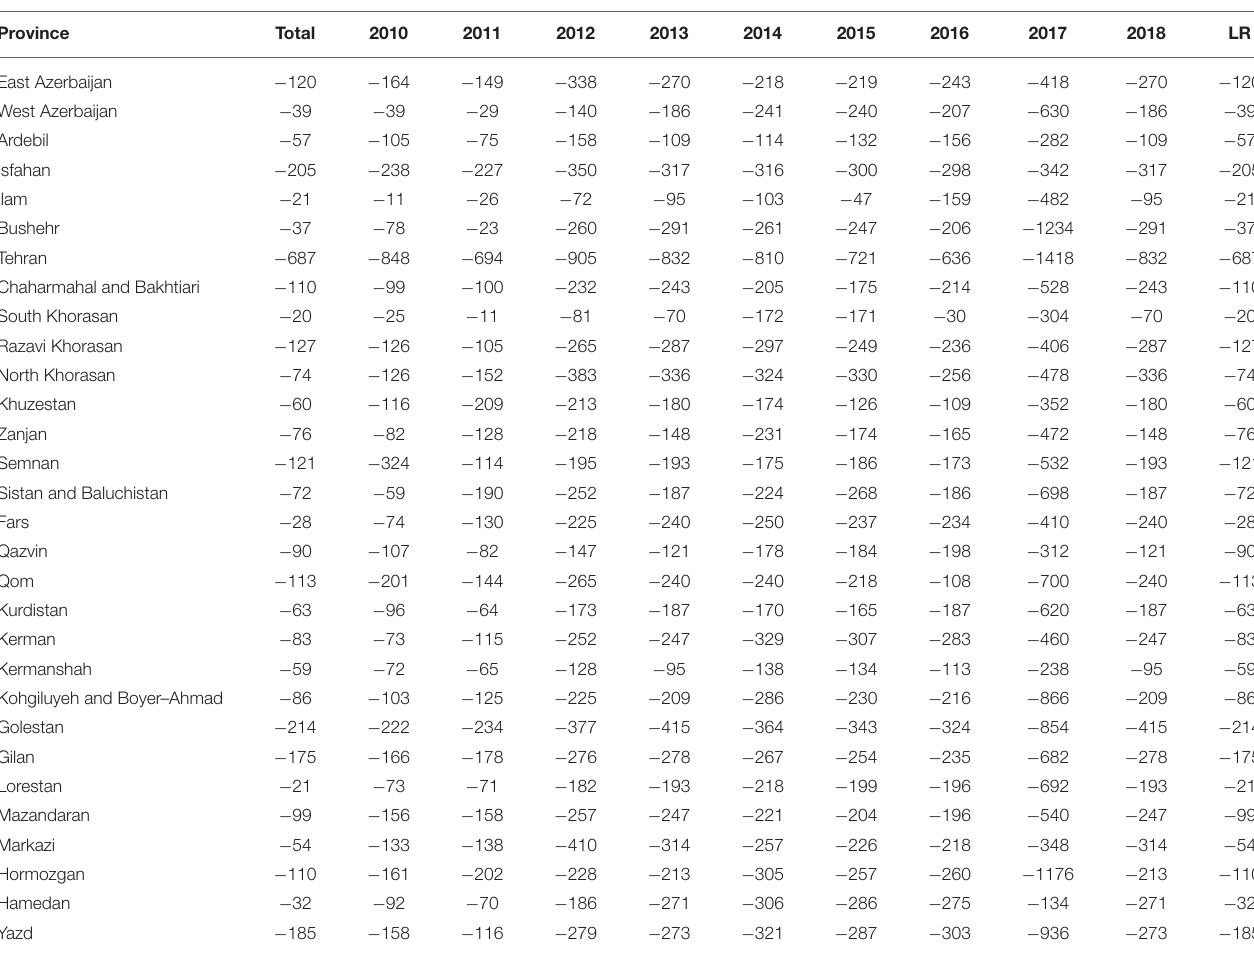
TABLE 5 | The result of the LR statistic for testing the possibility of aggregating provincial data.